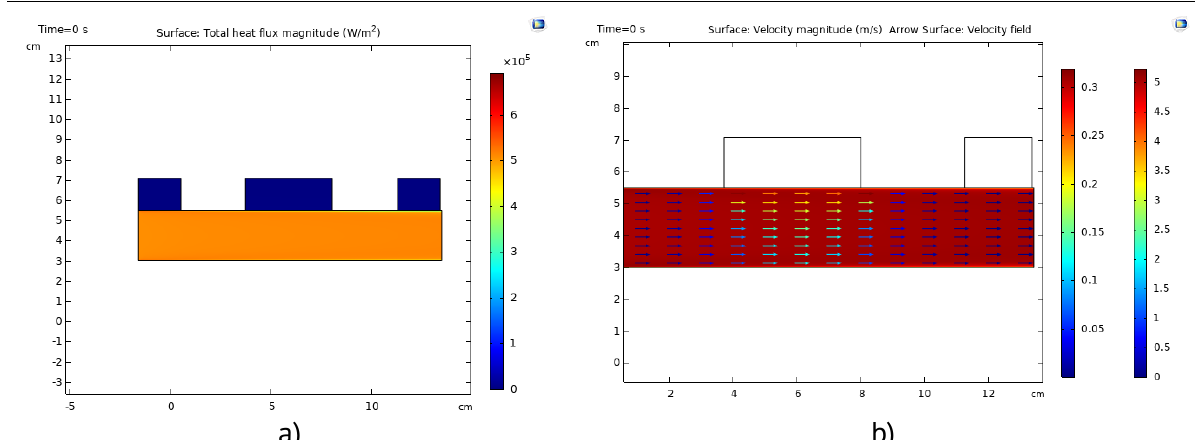
Figure 7. a) Total heat flux magnitude plot, b) combined arrow and surface velocity plot just after the start of the